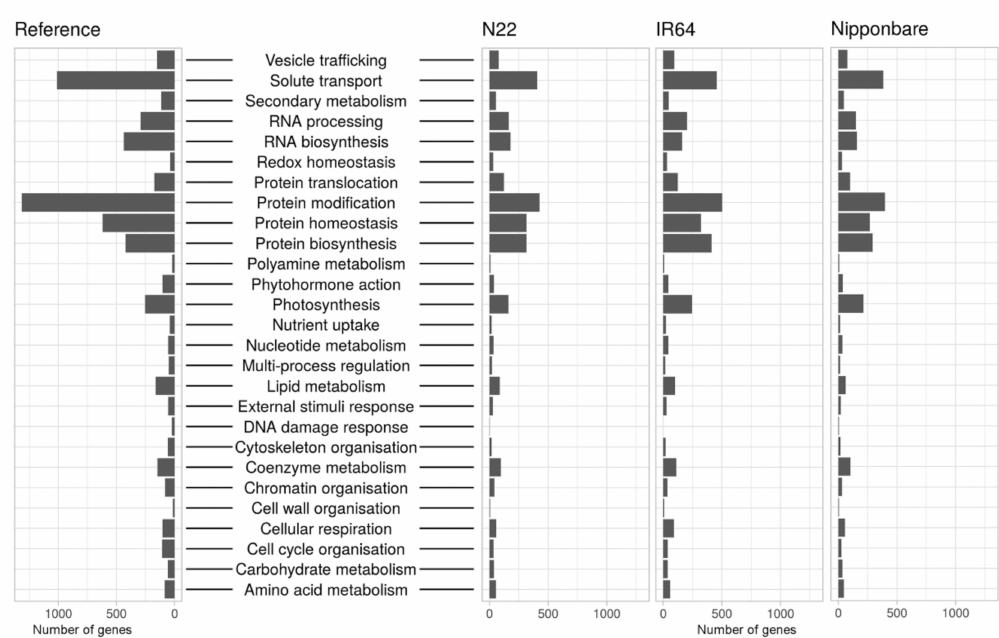
Figure 5. Classification of transcripts into functional bins. Transcripts of N22 ( aus ), IR64 ( indica ) and Nipponbare ( japonica ) were classified into functional bins using Mercator. The bins “not assigned.annotated” and “not assigned.not annotated” are not